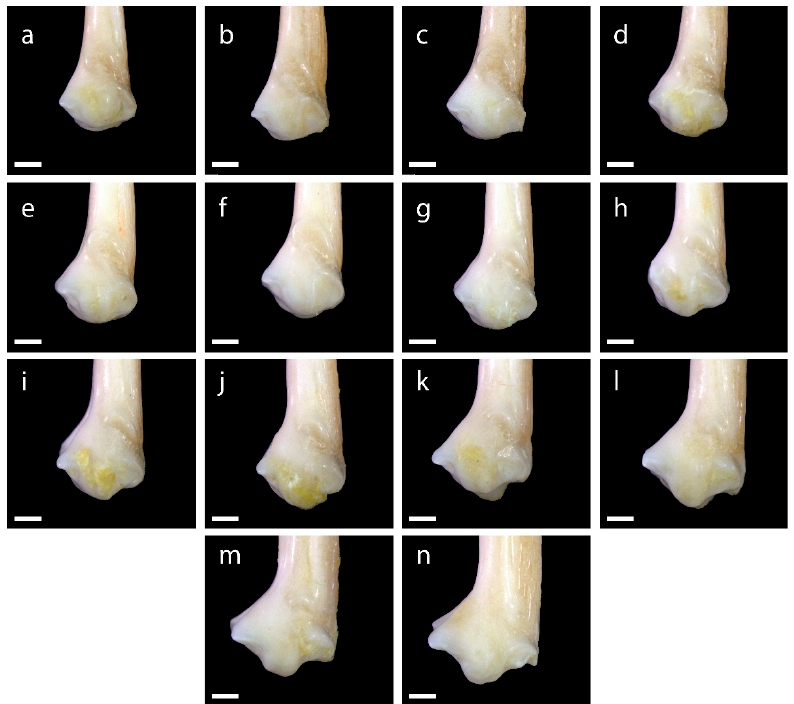
Figure A18. Microscopic images of the lateral right view of the pinnules of P. bichir PO3. The images ( a – n ) correspond to the 1st, 2nd, 3rd, 4th, 5th, 6th, 7th, 8th, 9th, 10th, 11th, 12th, 13th, and 14th pinnules, respectively. Scale = 1 mm.